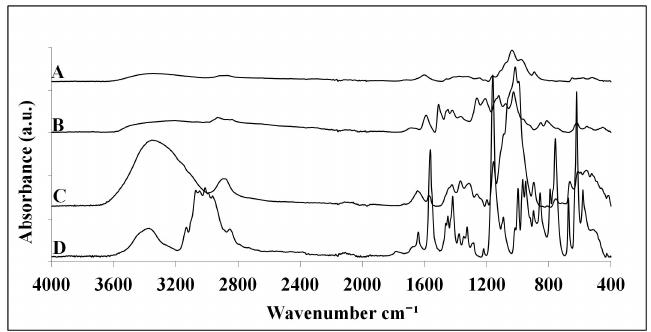
Figure 1. Attenuated total reflectance Fourier transform infrared (ATR-FTIR) spectra of pure material components. (A) Xylan; (B) lignin; (C) microscrystalline cellulose; and (D) AMIMCl.